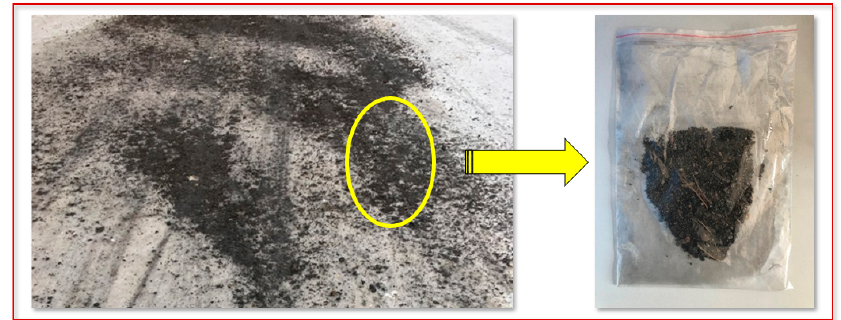
Figure 3. Anti-slip sand thrown on permeable pavement.